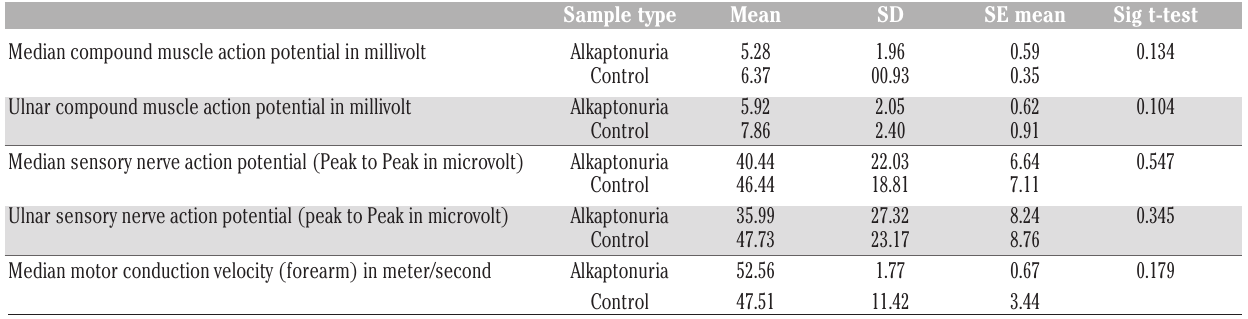
Table 3. Summary of the of nerve conduction study values in alkaptonuria patients and healthy